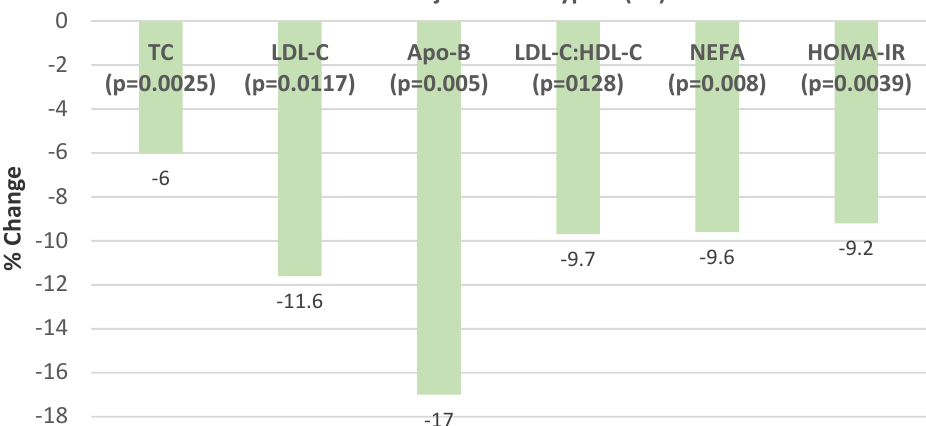
Figure 34. Effect of consuming an almond-supplemented NCEP Step 2 diet relative to a control in T2 diabetic subjects from baseline to 4 weeks [54].